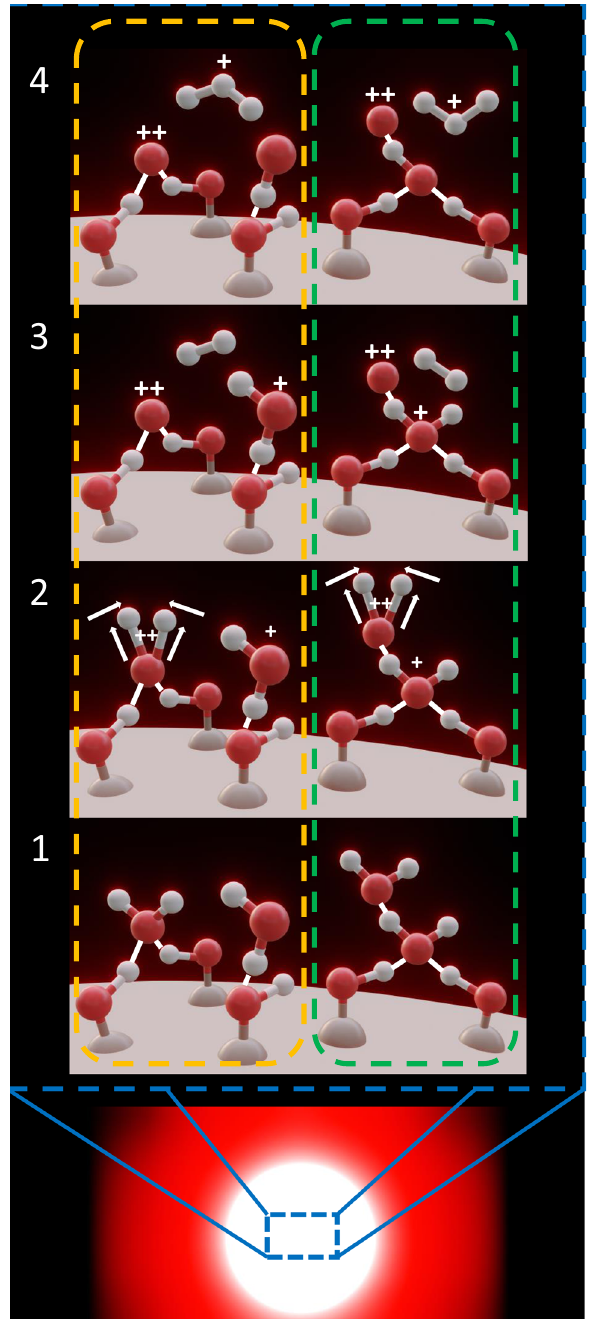
Fig. 4 Bimolecular reaction to form H þ from water molecules on SiO 2 3 nanoparticles. An illustration of two potential processes responsible from the formation of H þ from water molecules on the surface of silica 3 nanoparticles. The bottom panel demonstrates a nanoparticle in an intense laser fi eld. The orange dashed line depicts the formation of H þ from two 3 separate water molecules through a roaming on the surface mechanism. The green dashed line depicts the roaming mechanism within a water dimer. In both cases, there exist four stages. Stage 1 shows the ground state. Stage 2 shows the migration mechanism leading to the formation of a hydrogen molecule. Stage 3 is roaming close to another water ion. Stage 4 is the formation of H þ 3